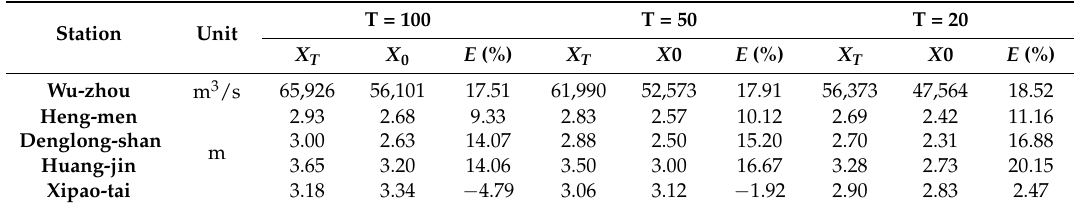
Table 3. Comparison of design